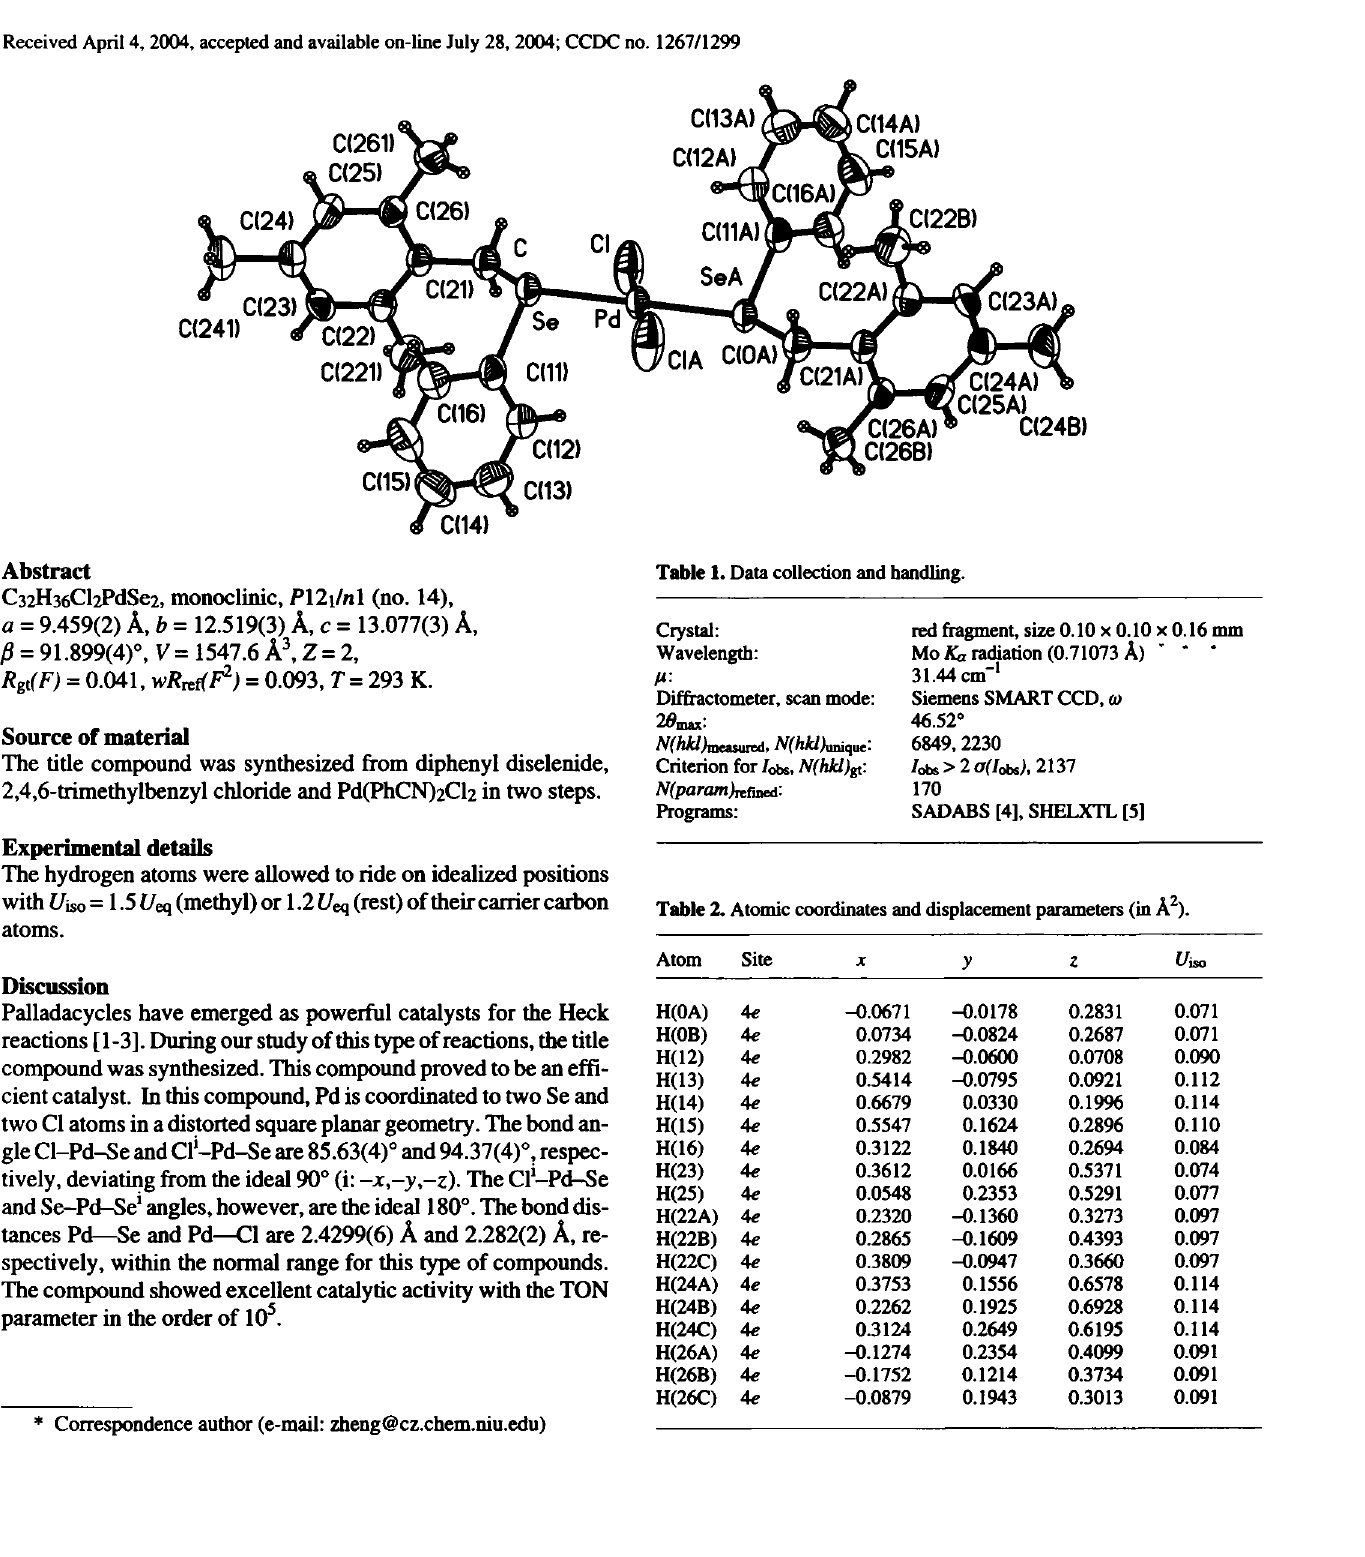
Table 1. Data collection and handling.